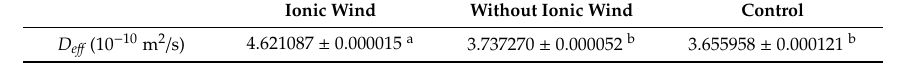
Table 5. E ff ective moisture di ff usion coe ffi cients under ionic wind and without ionic wind. Table 5. Effective moisture diffusion coefficients under ionic wind and without ionic wind. Ionic